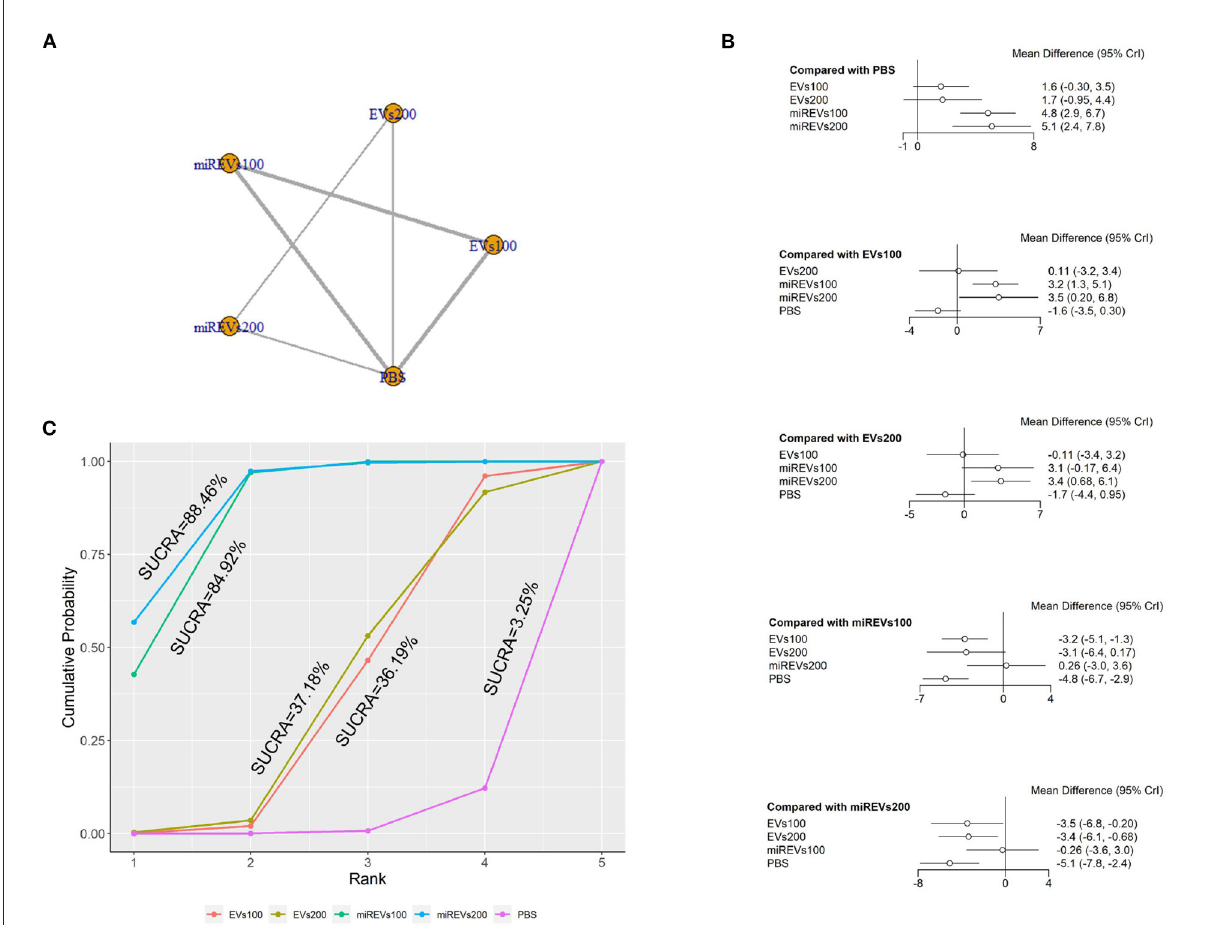
FIGURE5 The network meta-analysis of BBB scores at different dosages at 14 days after administration. (A) Network plot; (B) Forest plot; (C) SUCRA plot. EVs100, EVs at 100 µ g dosages; EVs200, EVs at 200 µ g dosages; miRExos100, miRNAs-loaded EVs at 100 µ g dosages; miREVs200, miRNAs-loaded EVs at 200 µ g